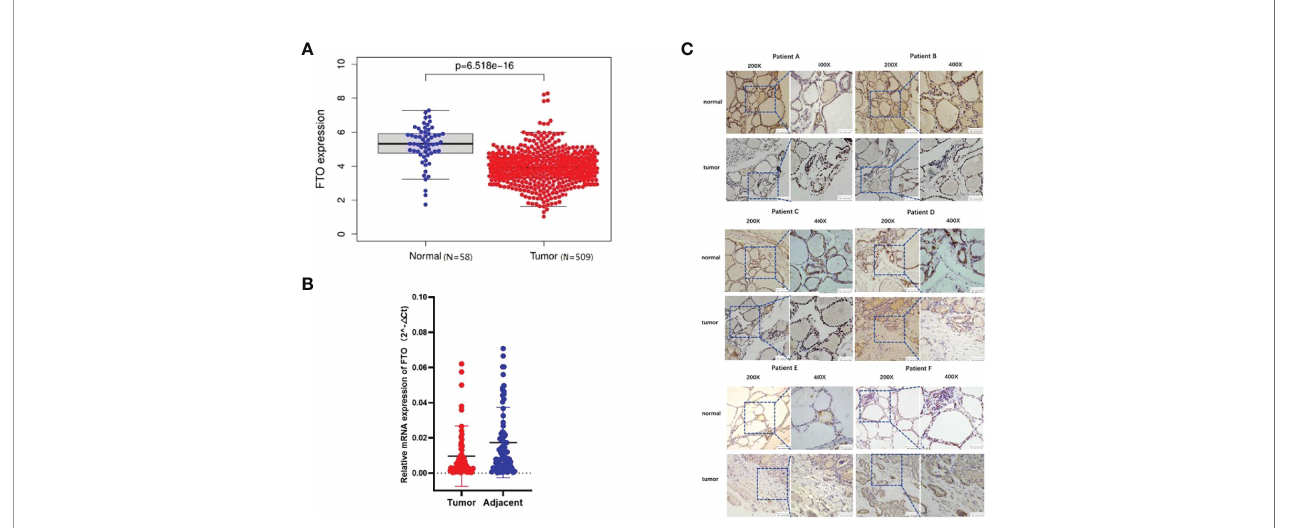
FIGURE 1 | Fat mass and obesity-associated protein (FTO) expression is downregulated in patients with papillary thyroid carcinoma (PTC). (A) In The Cancer Genome Atlas database, the expression of FTO in patients with papillary thyroid carcinoma and in normal people. (B) Expression of FTO in 86 pairs of PTC specimens as determined by RT-qPCR. (C) Representative images of immunohistochemistry staining for FTO in specimens from patients with